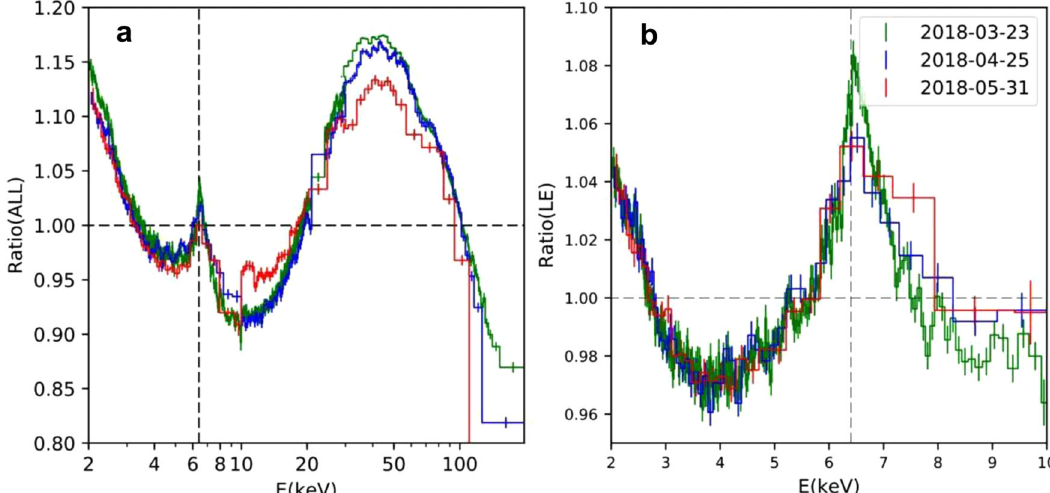
Fig. 2 Ratio of the spectrum to the best- fi tting cutoff power law. a Ratio of the spectrum of three epochs to the best- fi tting cutoff power law ( cutoffpl in XSPEC) in 2 – 200 keV. Time runs from top to bottom, corresponding to the early, middle and late echo of this decay, i.e., 2018-03-23 (MJD = 58201, ObsID = P0114661003), 2018-4-25 (MJD = 58233, ObsID = P0114661028), 2018-05-31 (MJD = 58269, ObsID = P0114661060). b Ratio of the spectrum of the same epochs to the best- fi tting power law in 3 – 10 keV. The vertical dashed line indicates the rest energy (6.4 keV) of the iron line. Fluorescence lines due to the photoelectric effect of electrons in the K-shell of silver are detected by the Si-PIN detectors of ME, which dominates the spectrum over 21 – 24 keV. Therefore, the spectrum over 21 – 24keV is